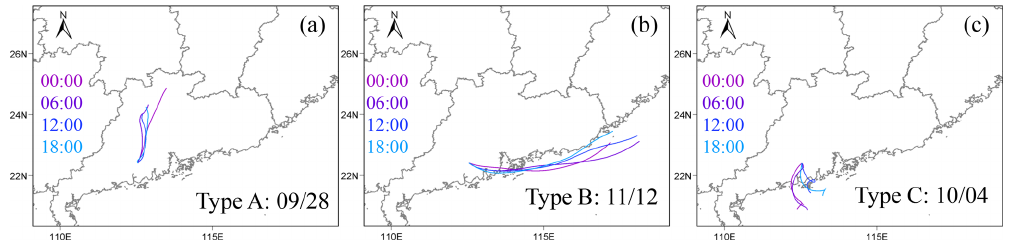
Figure 2. Three typical cases with air mass from different regions on 29 September, 12 November and 4 October respectively. Backward trajectory of 24h history of air masses arriving at the measurement site with 500m height at 00:00, 06:00, 12:00, and 18:00.